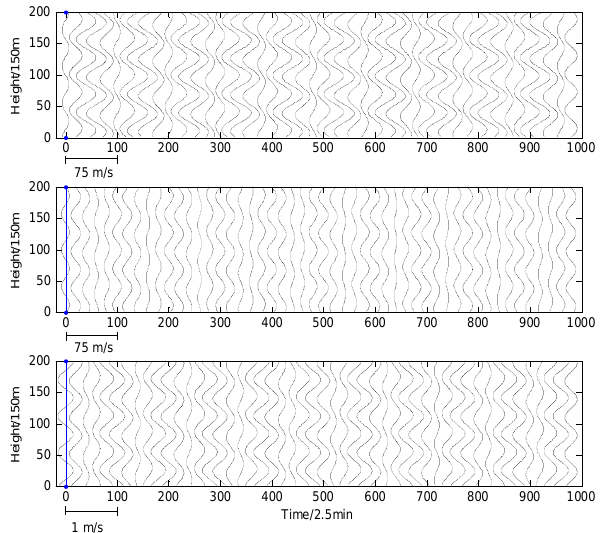
Fig.1 Height variations of perturbation velocities at successive times. Top panel : zonal velocity Fig. 1. Height variations of perturbation velocities at successive profile; Middle panel: meridional velocity profile; Bottom panel: vertical velocity profile. 5 times. Top panel: zonal velocity profile; middle panel: meridional The data were obtained from the superposition of two monochromatic waves characterized in velocity profile; bottom panel: vertical velocity profile. The data Table 1a with 0.5 α = in equations (8a, 8b, 8c). The time step is 2.5 minutes and the height were obtained from the superposition of two monochromatic waves resolution is 150 meters. The vertical lines indicated 0 m/s for the first profile, and successive characterised in Table 1a with α = 0 . 5 in Eqs. (8a), (8b), (8c). The time step is 2.5min and the height resolution is 150m. The verti- profiles are 50 minutes apart. The velocity scales are indicated below each panel. cal lines indicated 0ms − 1 for the first profile and successive pro- files are 50min apart. The velocity scales are indicated below each panel.